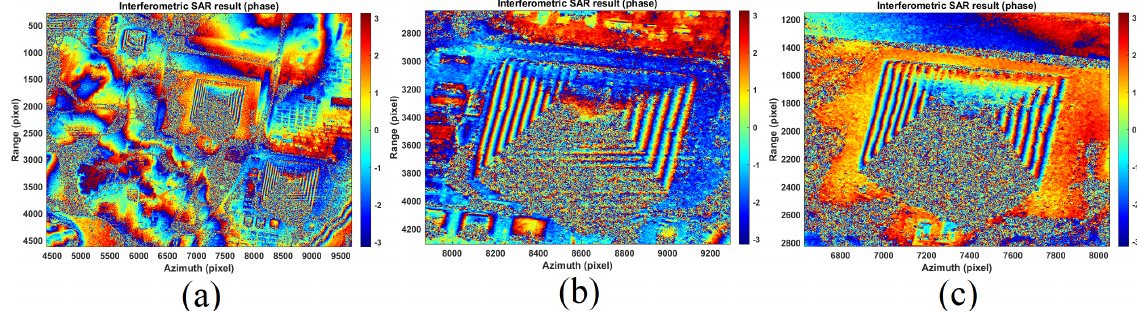
Figure 12. Interferometric SAR results. ( a ): Interferometric fringes of the Giza plateau. ( b ): Interfero- metric fringes of Khnum-Khufu. ( c ): Interferometric fringes of Khefren.